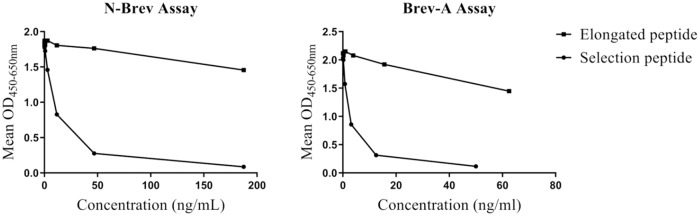
Peptide selectivity test of monoclonal anti-N-Brev and anti-Brev-A antibodies.The binding of antibodies to selection peptides and elongated peptides of concentrations within the measuring range of each assay are shown. For both antibodies, an addition of a single amino acid (elongated peptide) disrupted the binding to a satisfying extent. Selection and elongated peptides were diluted in assay buffer.